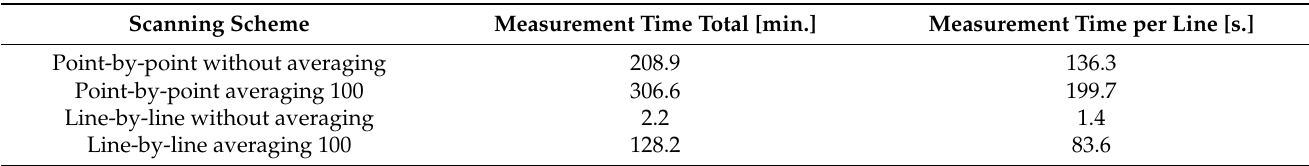
Table 1. Measurement times for different scanning schemes.